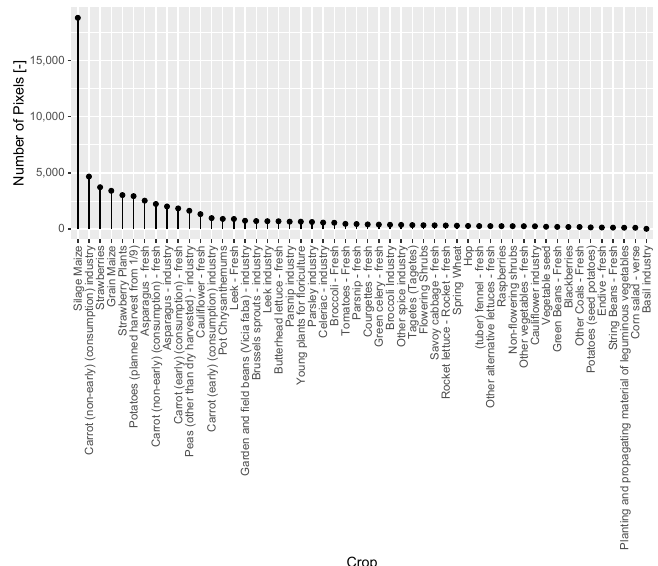
Figure 19. The RED-NIR scatters (shown in a density plot) of Sentinel-2 pixels of agricultural parcels with NDVI < 0.3 and with the exclusion of artificially covered parcels and CC anomalies. ( a ) Rank 1, ( b ) Ranks 1 and 2 composite, ( c ) Ranks 1, 2, and 3 composite.